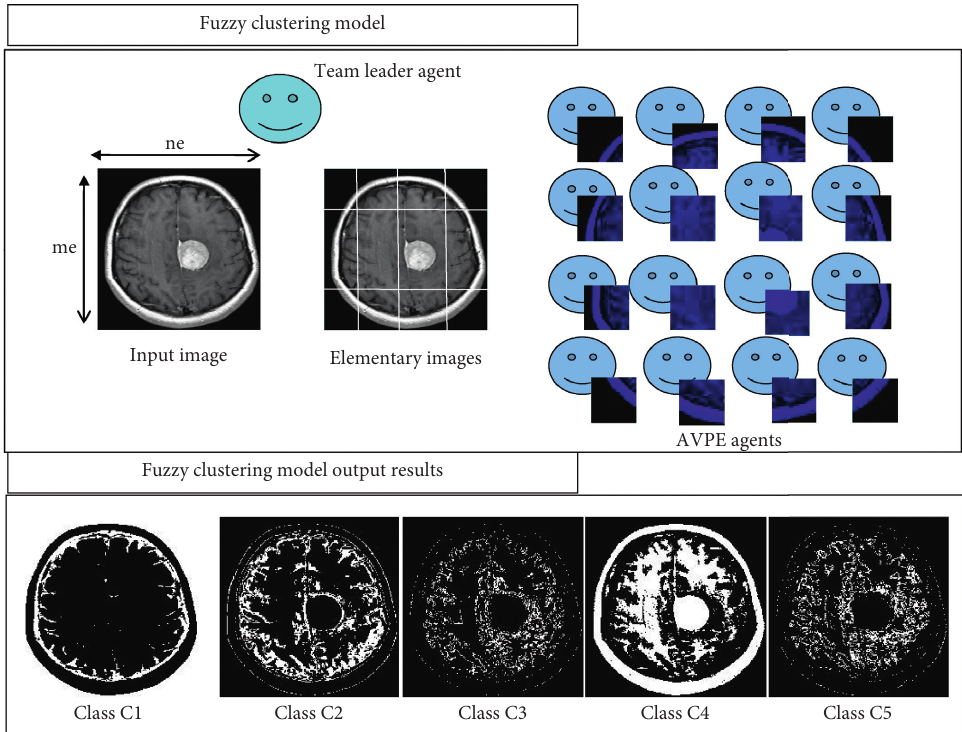
Figure 5: The proposed method’s output clustering